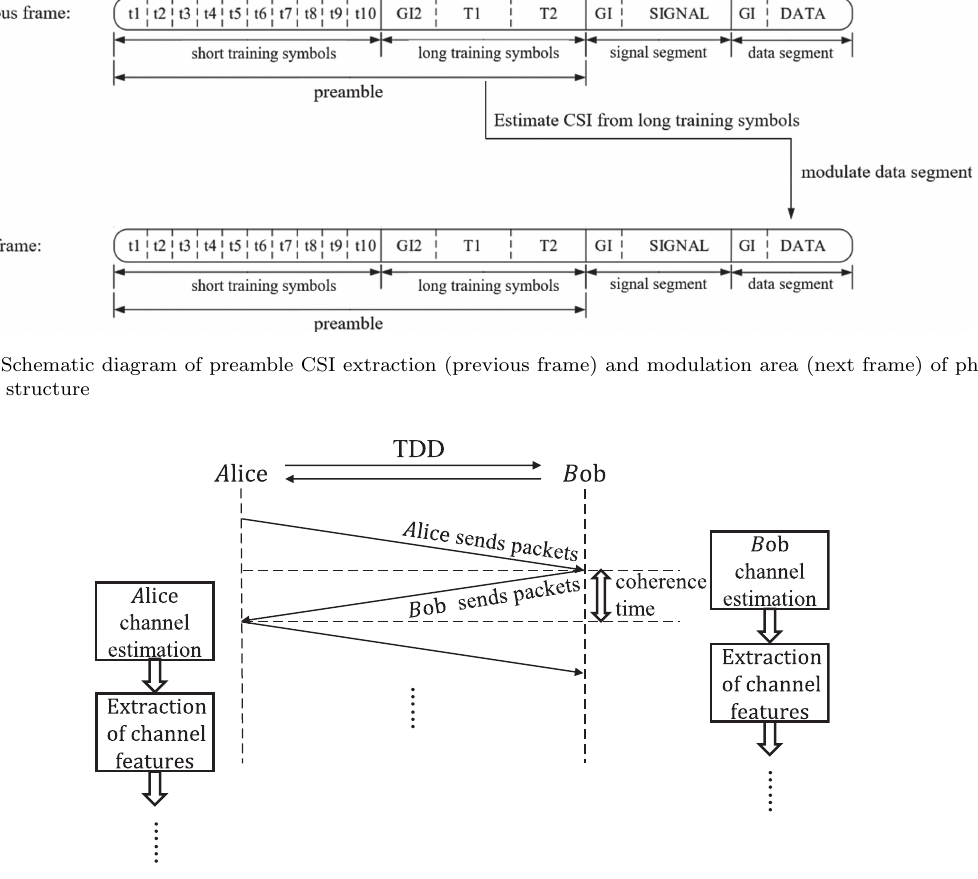
Figure 3. Extraction process of channel